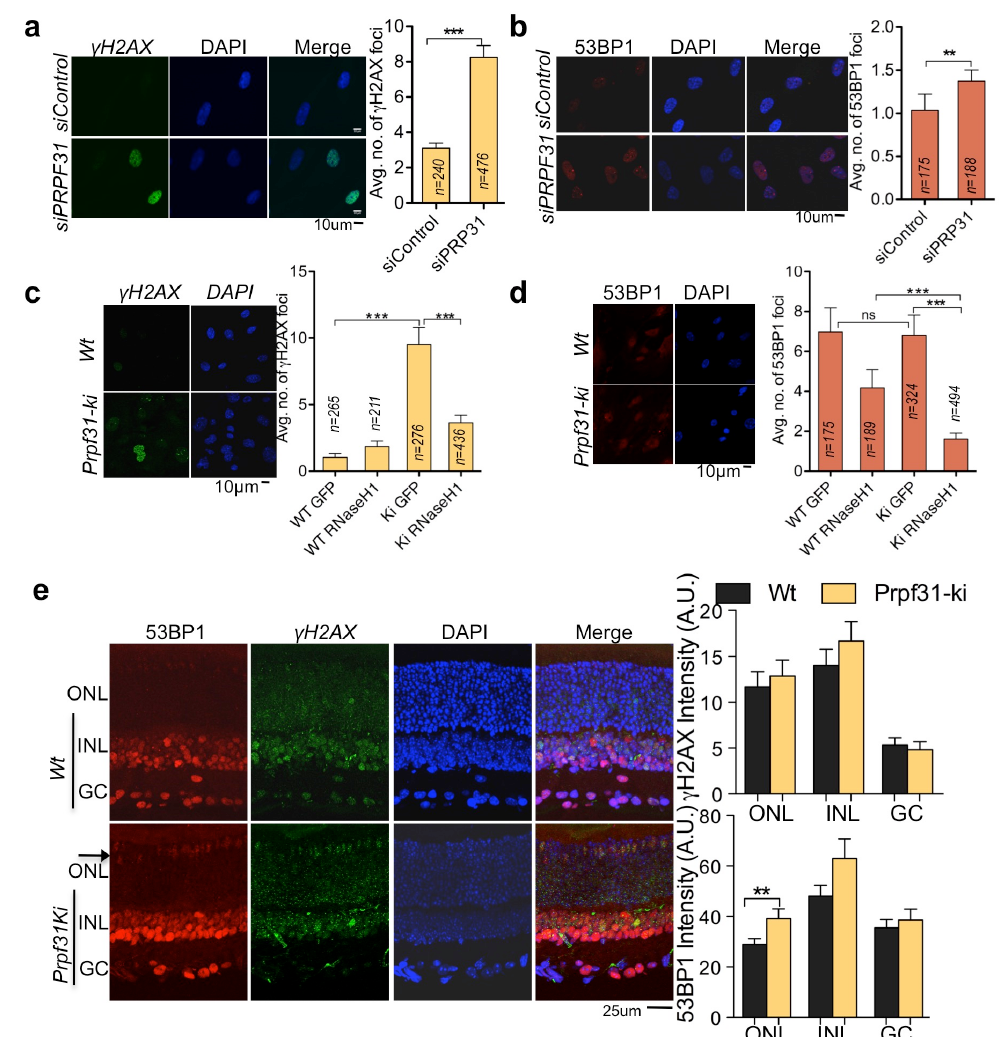
Figure 2. Loss of functional PRPF31 induce RNA:DNA hybrid dependent genomic instability but not in mice retinal neurons. ( a and b ) γ H2AX and 53BP1 foci analysis in PRPF31 siRNA-transfected RPE-1 cells. (c and d) γ H2AX and 53BP1 foci analysis in vasculo- stromal fraction derived primary cells from Prpf31 +/A216P mice ( Prpf31-ki ) . ( e ) γ H2AX and 53BP1 foci analysis in retina from Prpf31 +/A216P mice on postnatal day 20. All column bars represent the mean. For ( a - d ) “n”, mentioned on respective column, signify number of cells analyzed from two independent experiments. For ( e ) n=16 for each column and signify number of retinal sections analyzed; acquired from n=4 eyes. Error bars represent Standard error of Mean (SEM). *P ≤ 0.05; **P<0.01, ***P<0.001 using Mann-Whitney test ( a , b ), Kruskal-Wallis test followed by Dunn’s post hoc test ( c , d ); and two tailed unpaired Student’s t-test ( e